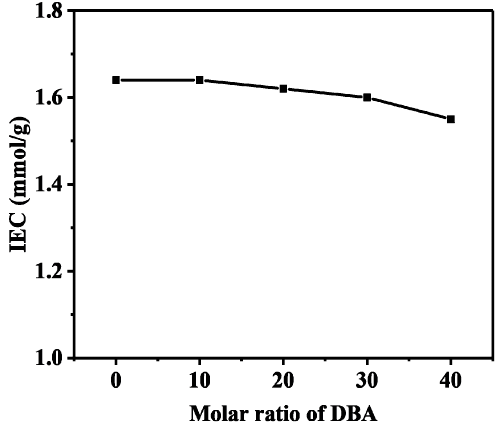
Figure 6. The ion exchange capacity (IEC) values of CSPEN-60-DBA-x.